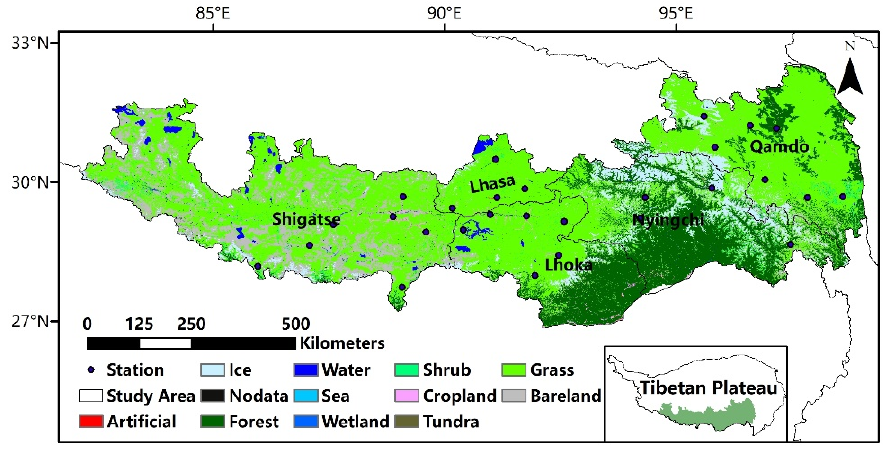
Figure 1. Land-use types in southeastern Tibet.